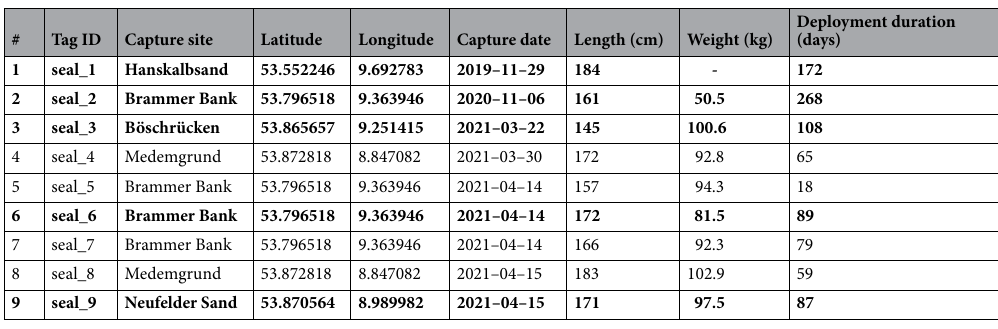
Table 1. Details on harbour seals caught in the Elbe estuary and equipped with an SMRU GPS Phone Tag. Females = bold.